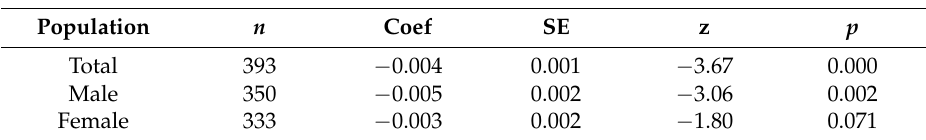
Table A3. Adjusted Poisson log-linear model with daily arsenic dosage ( µ g/day), 1.1 L/day; ≥ 80% dependency, As(Max) ≤ 50, and ND = 1/2 LOD.